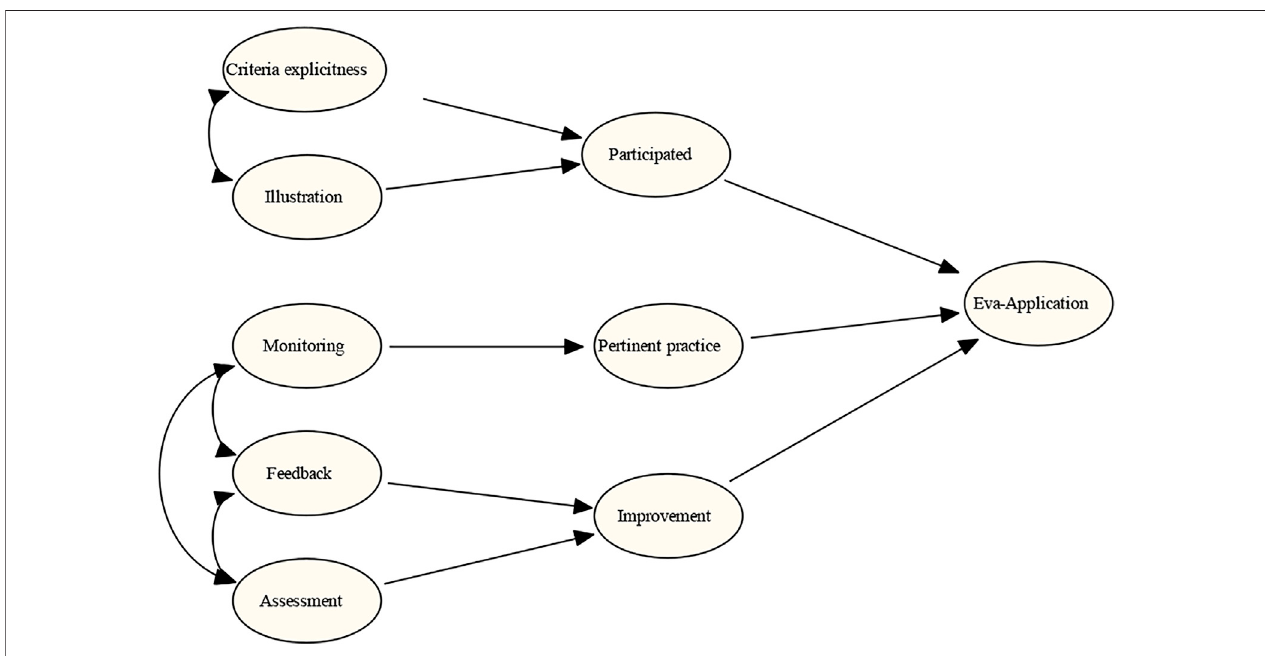
FIGURE 1 | Theoretical model to explain didactic performances of the teacher and the student. Note. Teaching performance variables: criteria explicitness and illustration. Performance variables of teacher feedback: monitoring (practice supervision), feedback, and assessment. Student performance variables: illustration – participated, pertinent practice, feedback – improvement, and evaluation –